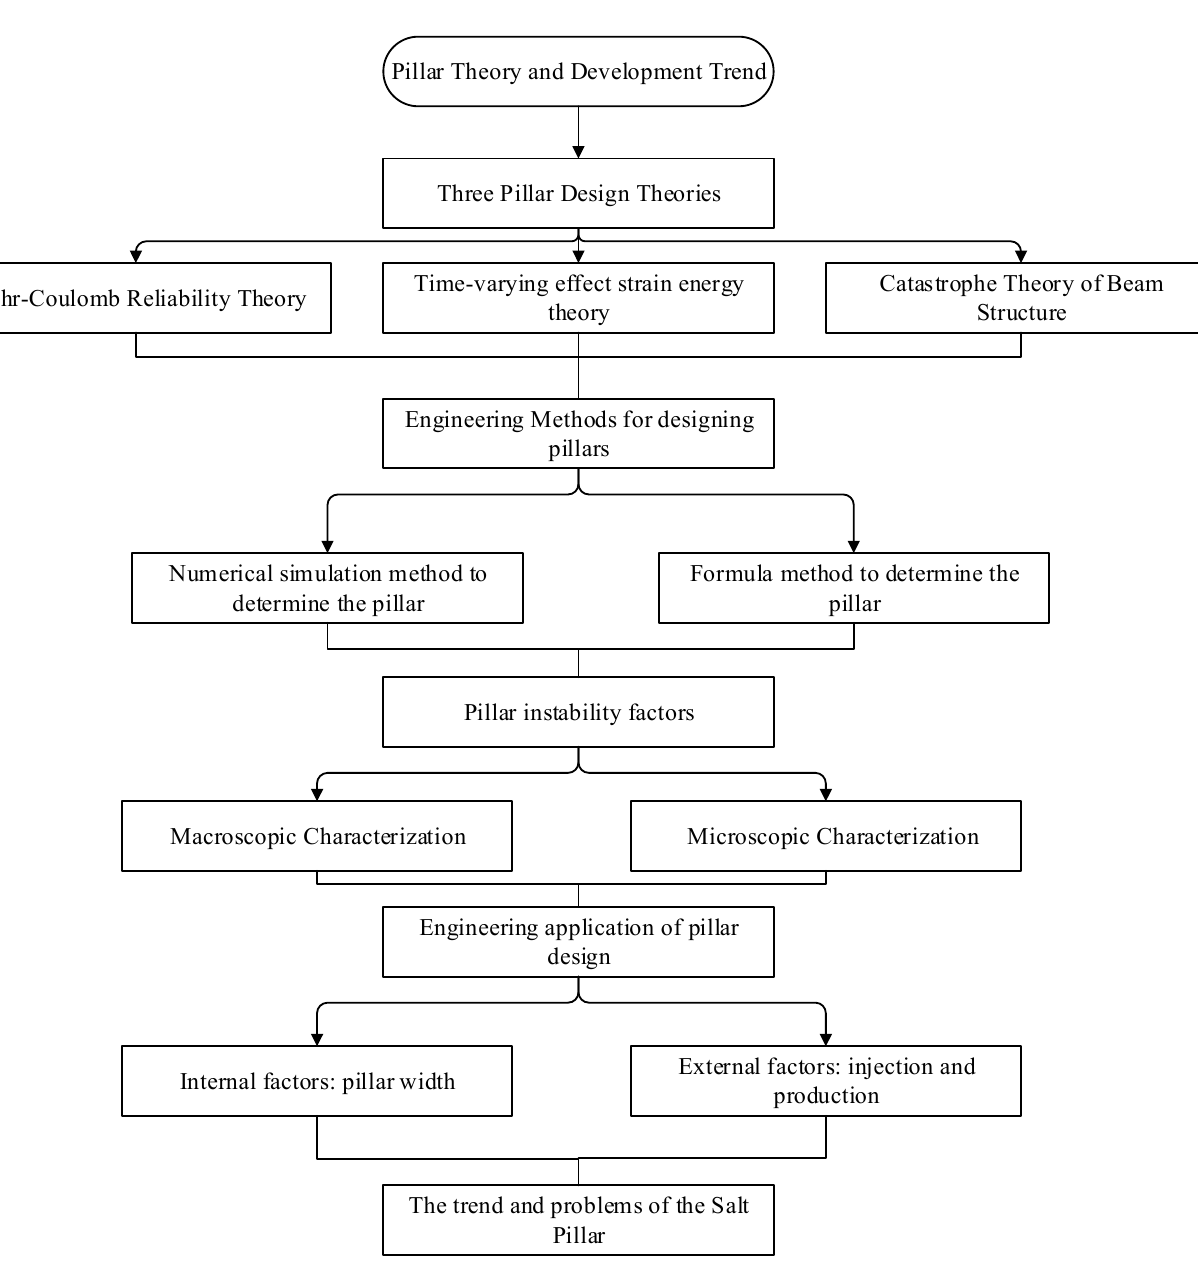
Figure 11. The development diagram of pillar theory.